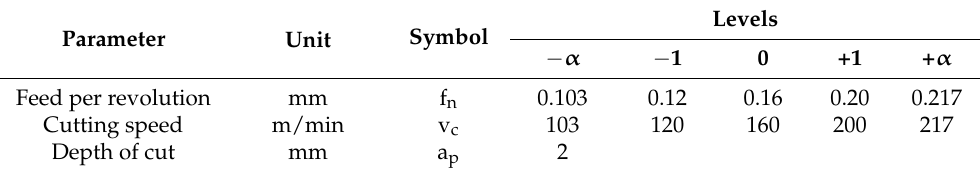
Table 3. Cutting conditions for the different levels of the central composite planning.